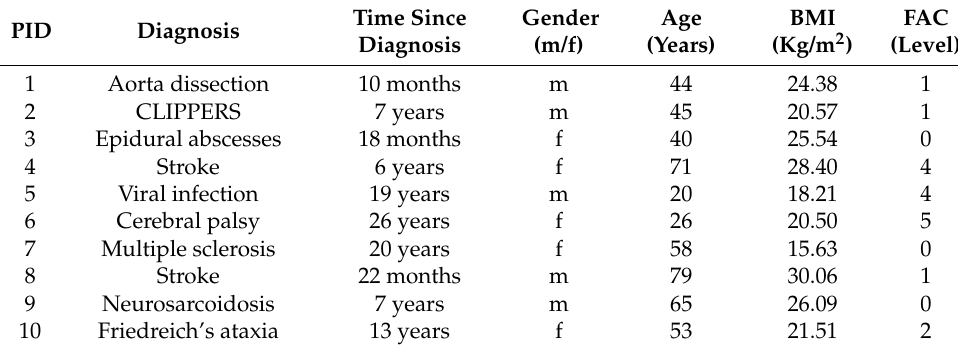
Table 1. Demographic and clinical features of